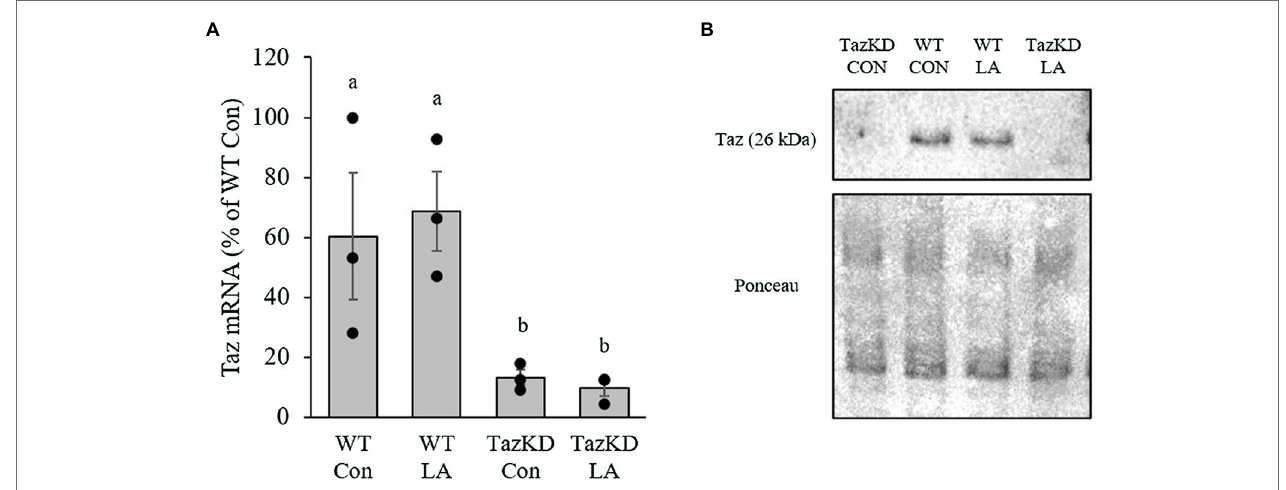
FIGURE 2 | Administration of doxycycline in either control or supplemental linoleic acid diet resulted in a significant reduction in tafazzin (Taz; A ) mRNA and (B) protein content in soleus of Taz knockdown (TazKD) male mice compared to their wild-type littermates. Values are means ± SEM, n = 3 for Taz mRNA. WT, wild